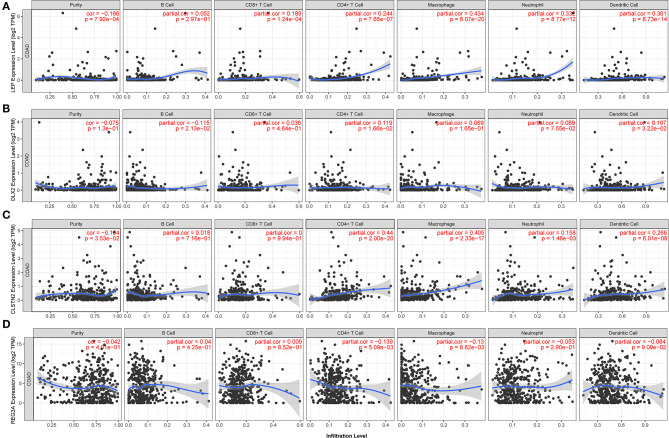
Correlations of the four prognosis-related genes with various immune cells in COAD (TIMER). The correlation between the abundance of immune cell and the expression of (A) LEP, (B) DLX2, (C) CLSTN2, and (D) REG3A. The x axis indicates the prognosis related genes and y axis indicates immune cell types. Each dot represents a sample, and the blue line represents the relationship between the expression level of each gene and immune cell contents.